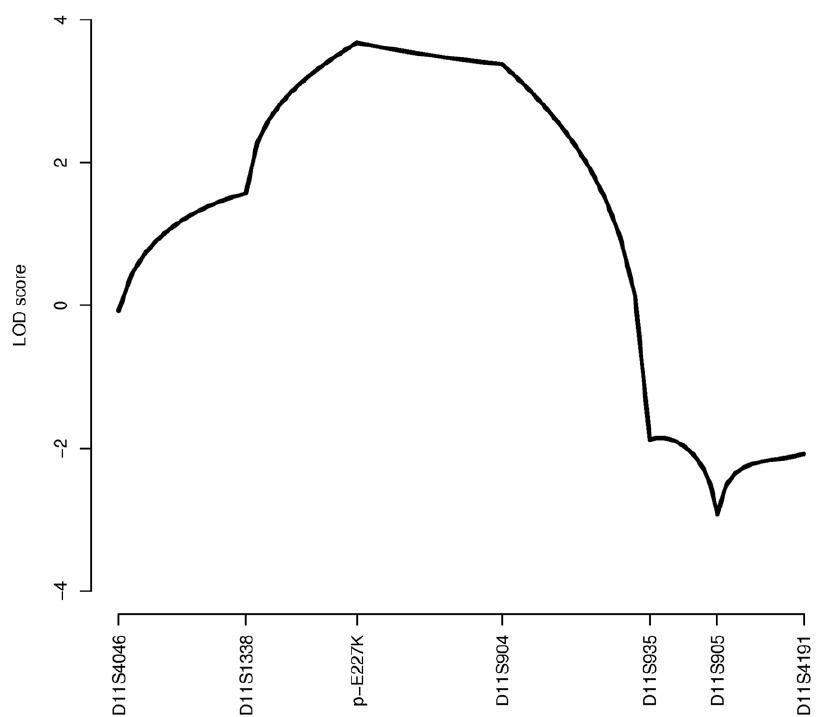
Figure 2. Multipoint linkage analysis following a dominant parametric model in the French pedigree. The positions of the genetic markers are ordered from chromosome 11p15.5 to 11q12.2 (chr11:1,820,211–59,856,421; positions given according to human genome assembly GRCh37/hg19).